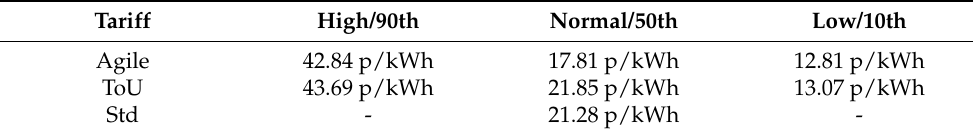
Table 3. Applied tariffs comparison. The percentiles refer to the prices in the RT tariff.